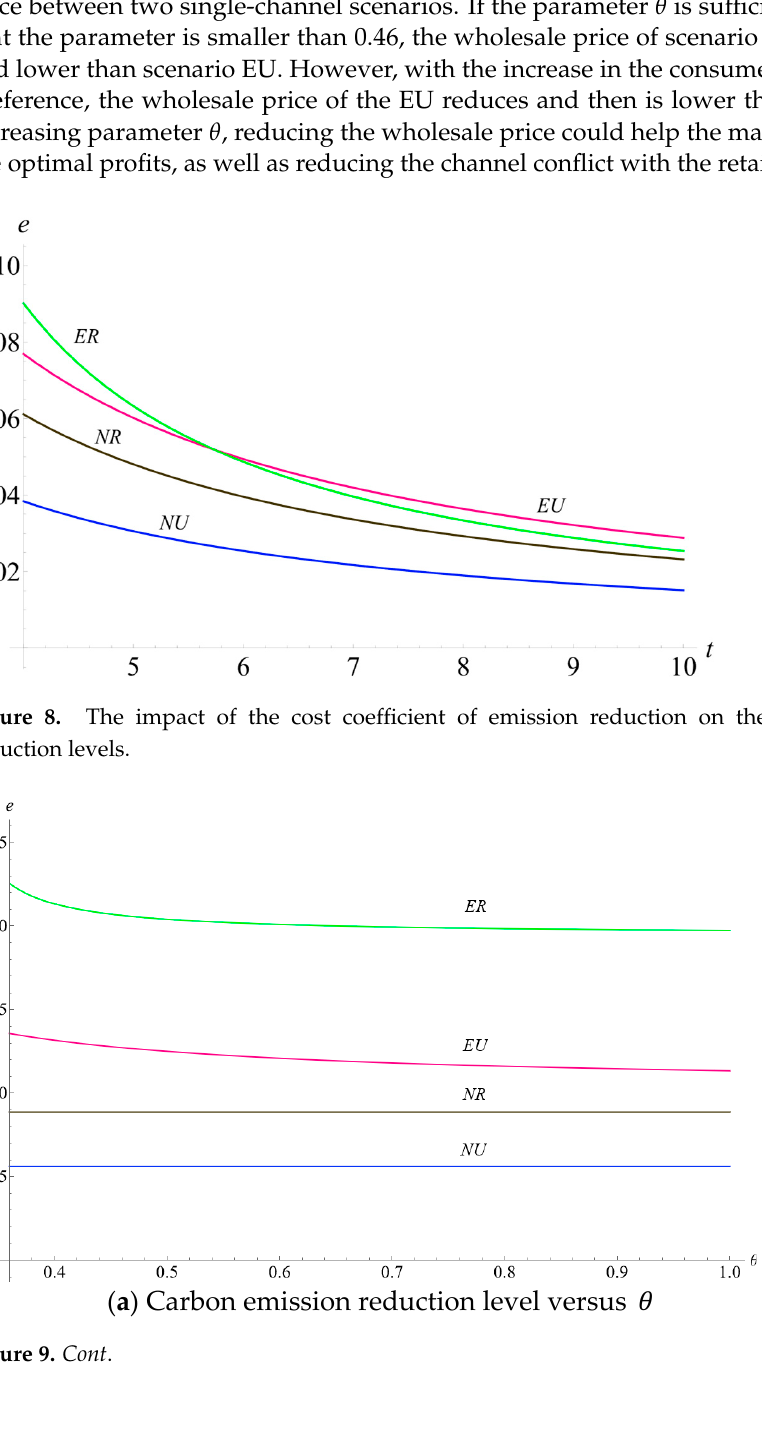
Figure 7. The impact of 𝑒 (cid:2868) and 𝑝 (cid:3032) on the optimal manufacturer’s profits when the total carbon quota is insufficient ( 𝑆 = 0.15 ) and sufficient ( 𝑆 = 0.45 ).